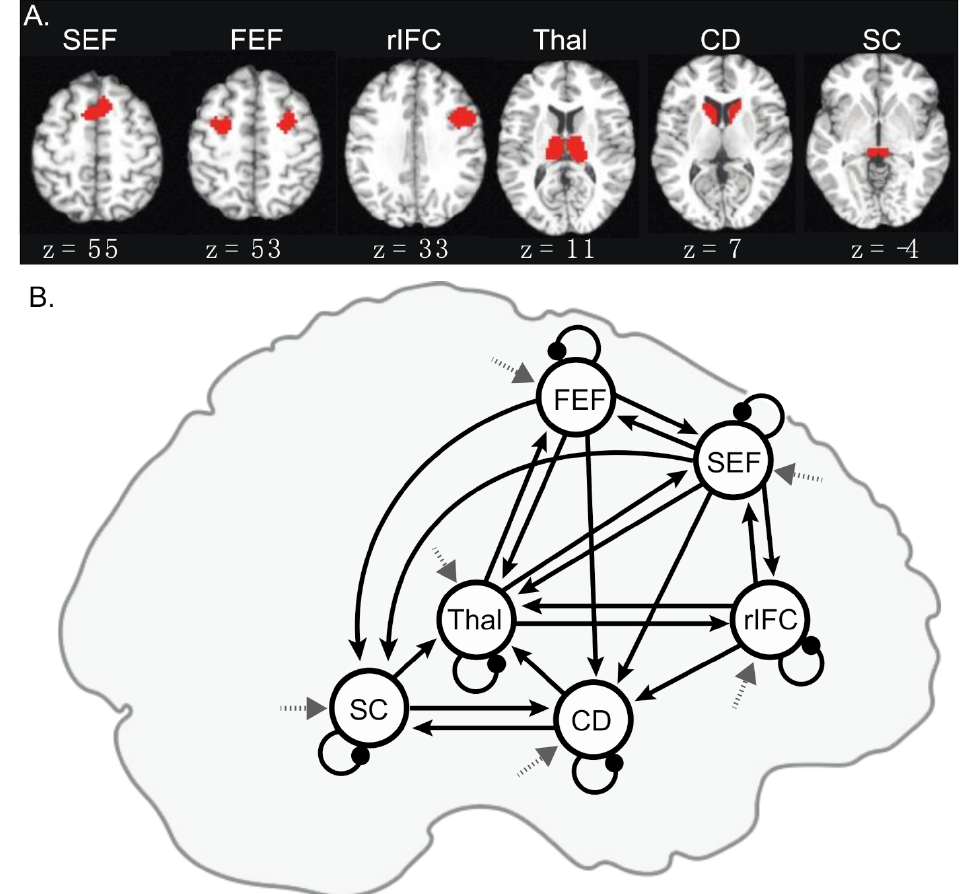
Figure 2. Regions of interest (ROIs) and the full model for the dynamic causal modeling analyses. ( A ) Visualization of the regions of interest with the corresponding MNI z-coordinate for each slice. ( B ) The connections that were used in the full DCM model. Between-region connections (solid arrows), inhibitory self-connections (dot tipped arrows), and driving input (grey arrows with dashed lines) were all switched “on.” The modulation of all between region connections and inhibitory self-connections was modeled. (SEF: supplementary eye field (bilateral); FEF: frontal eye fields (bilateral); rIFC: right interior frontal cortex; Thal: thalamus; CD: caudate; SC: superior